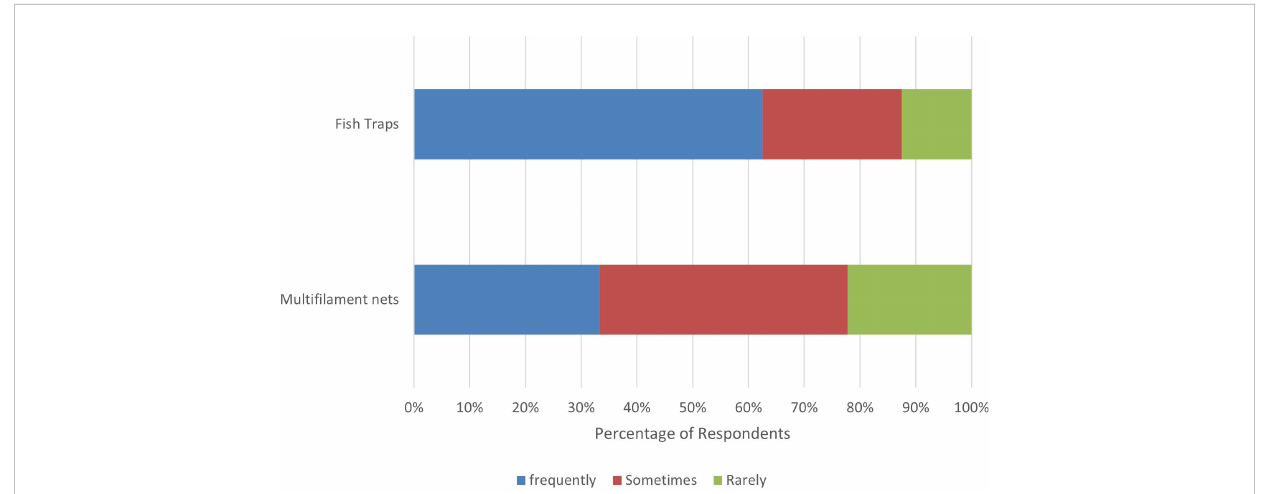
FIGURE 9 Encounter rates of derelict traps and multi- fi lament/polypropylene nets by divers in Antigua and Barbuda (n = 9).